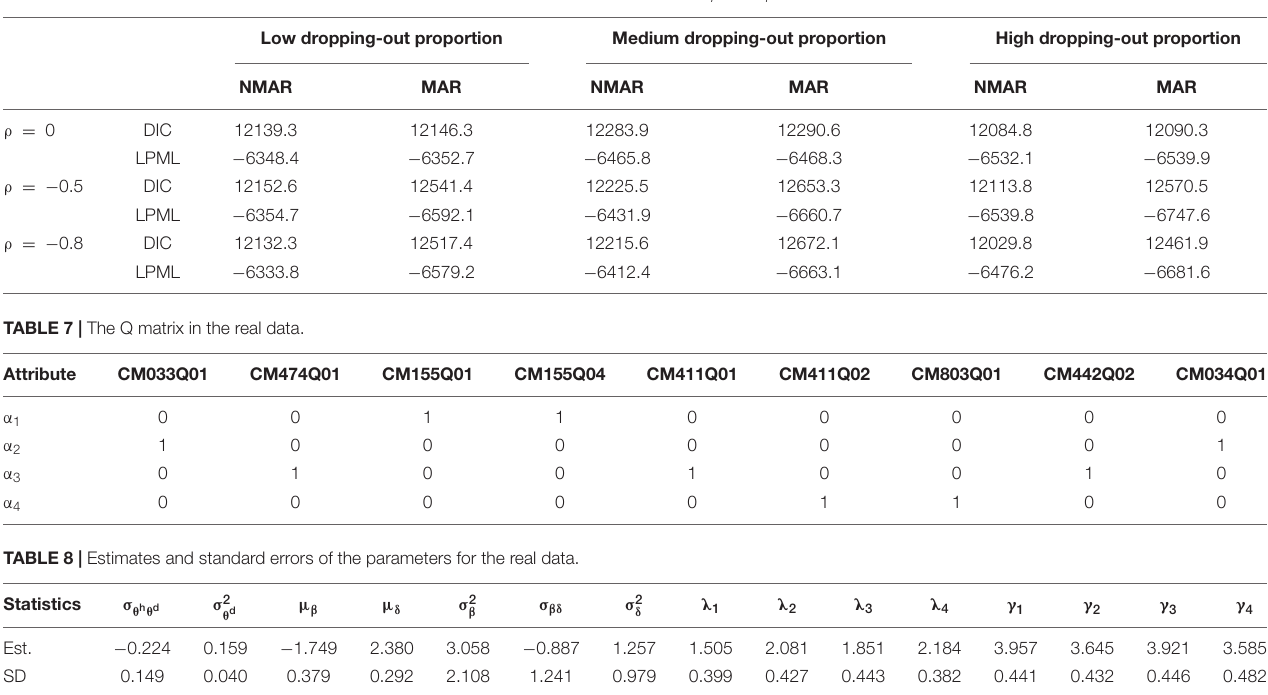
TABLE 6 | DICs and LPMLs of NMAR and MAR models under different correlations between θ h i and θ d i and different dropping-out proportions in simulation study III.